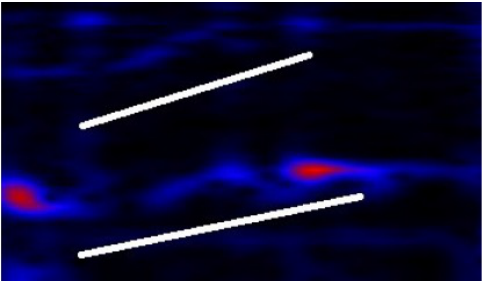
Fig. 18. Group II’s spectrogram of the fretter slide effect from C3 to E3 (through an amplifier).